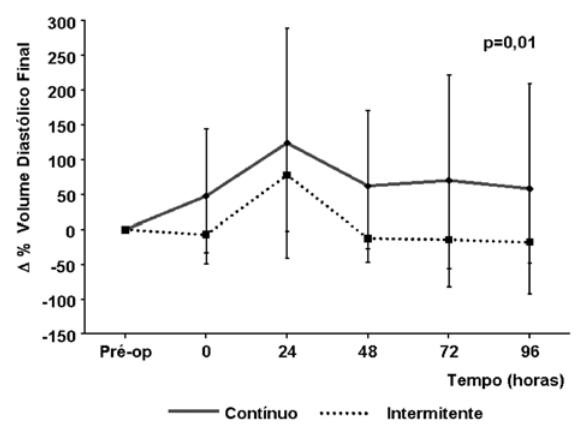
Fig. 4 - Variação do volume diastólico do Ventrículo Direito (VD). Variação porcentual do volume diastólico final do VD dos grupos submetidos à sobrecarga sistólica contínua versus intermitente de VD. (p=